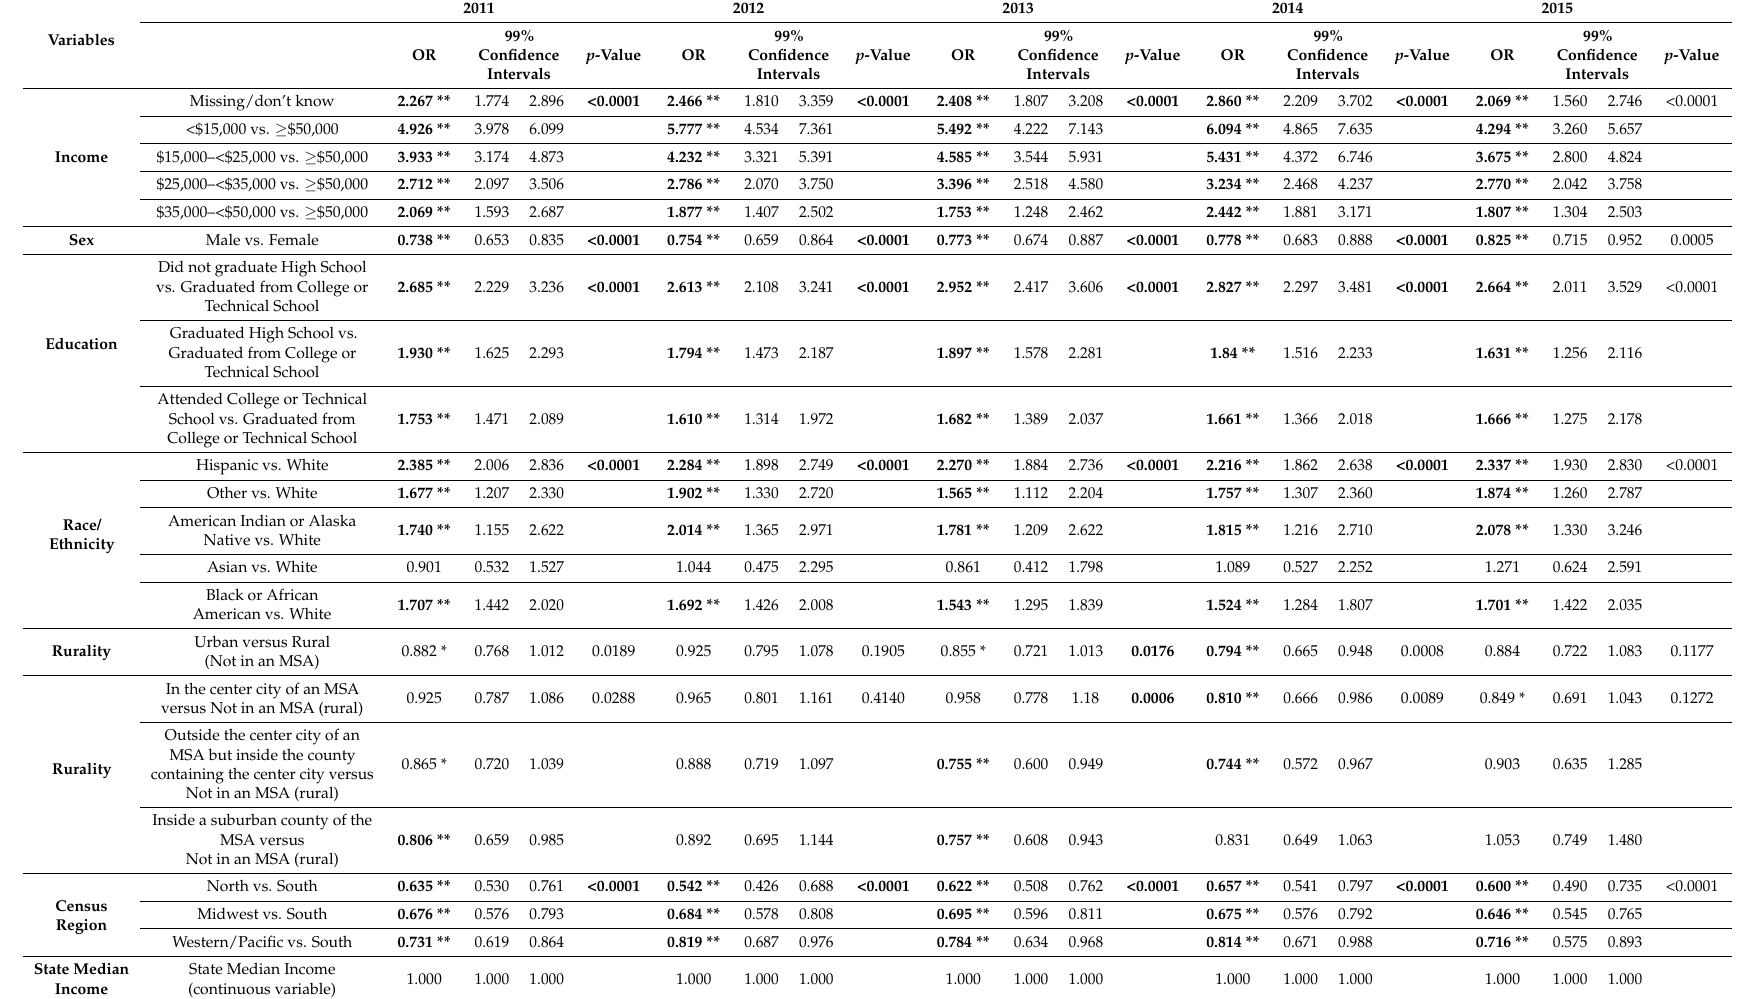
Table 4. Unadjusted analysis for forgone medical care among those diagnosed with